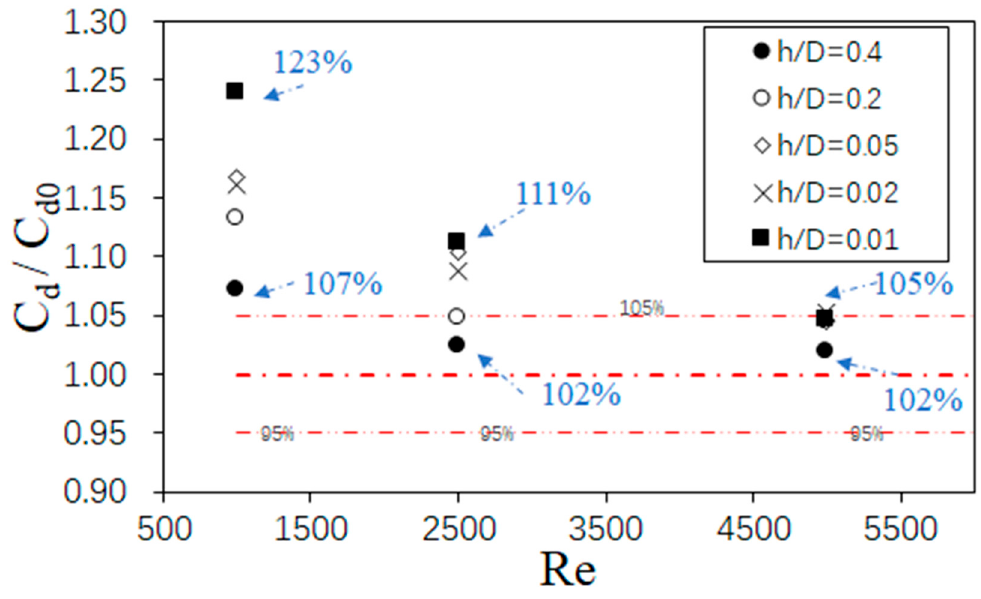
Figure 9. Discharge coefficient ratio as dependent upon Re j ranging from 1000 to 5000 for different micro cooling units heights.